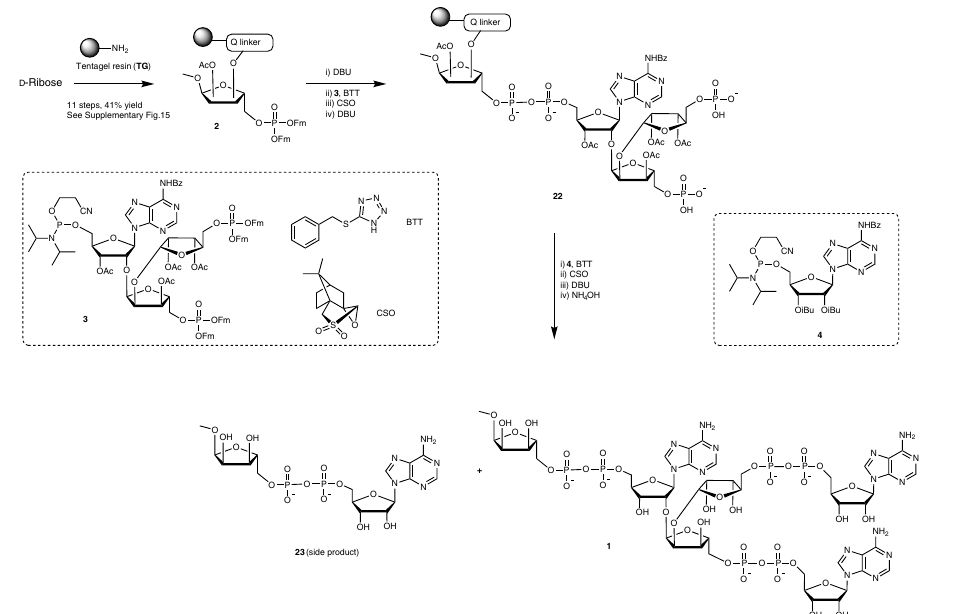
Fig. 4 Solid-phase synthesis of branched ADPr-trimer (1). Riboside immobilized on TentaGel resin 2 is synthesized from D -Ribose in eleven steps, then phosphoramidites 3 and 4 are coupled sequentially to furnish branched trimer 1 . Monomer 23 is found as a side product. Yield after each step is given as percentage in brackets. The two dotted boxes show the chemical structures of the building blocks (phosphoramidite 3 and 4 ) and reagents (BTT, CSO) used in these reactions. DBU 1,8-diazabicyclo(5.4.0)undec-7-ene, BTT 5-benzylthio-1 H -tetrazole, CSO (1 S )-( + )-(10-camphorsulfonyl)oxaziridine, NH 4 OH ammonia